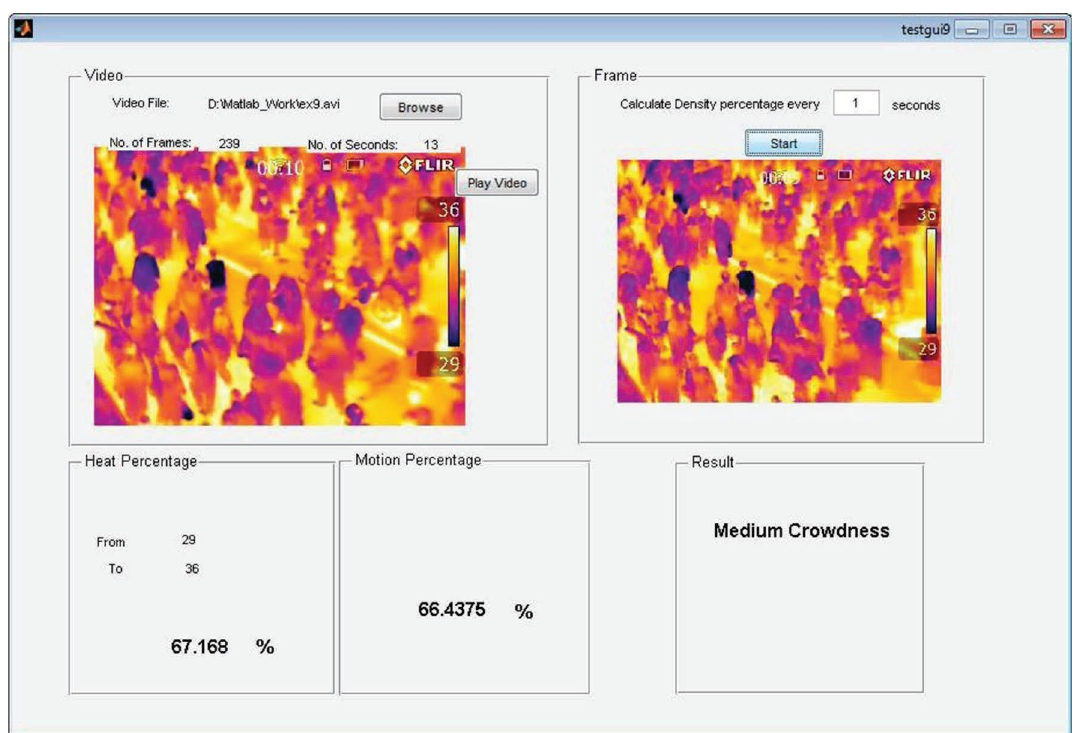
Figure 16: Sample result of real-time GUI for medium